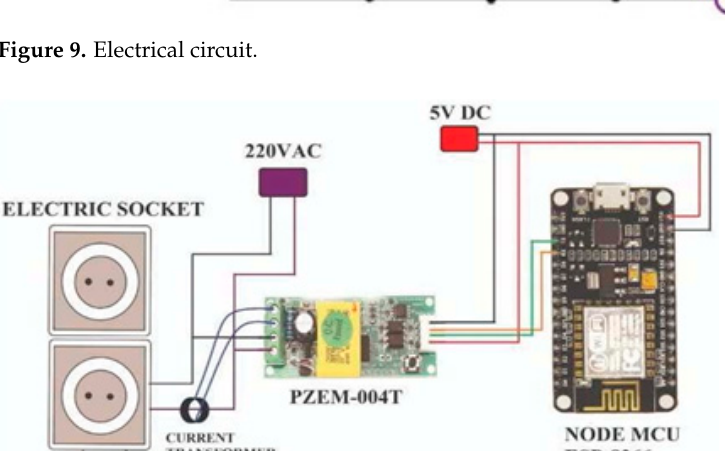
Figure 10. The current consumption monitoring system’s circuit connection layout.